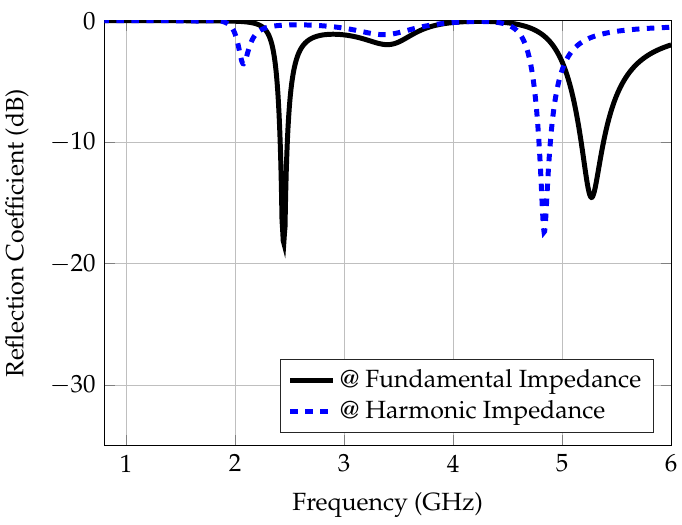
Figure 5. EM simulation of the reflection coefficient over the complete frequency span at the funda- mental and harmonic impedances of the